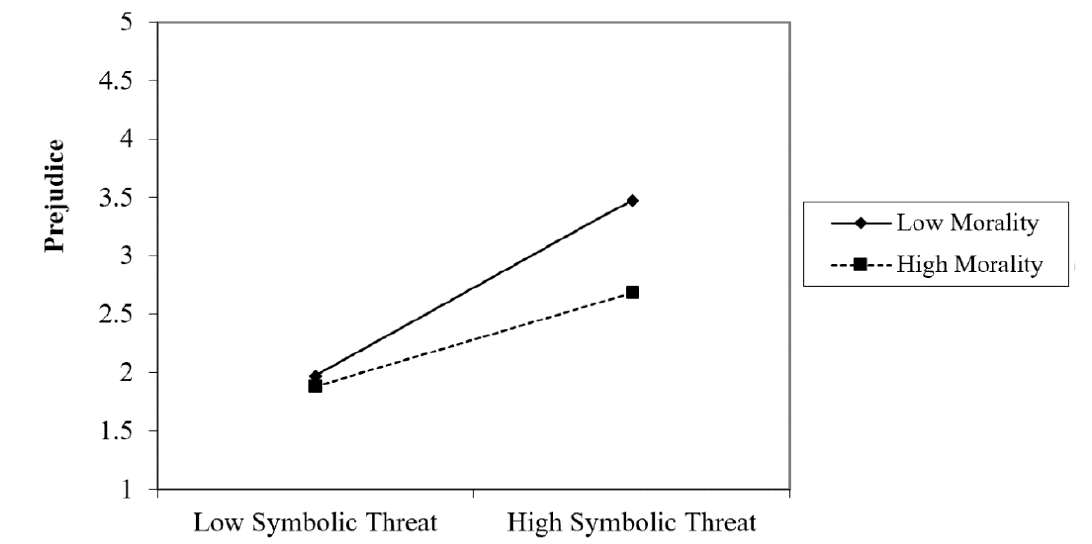
Figure 2. Interaction between Symbolic Threat and Morality on Prejudice.